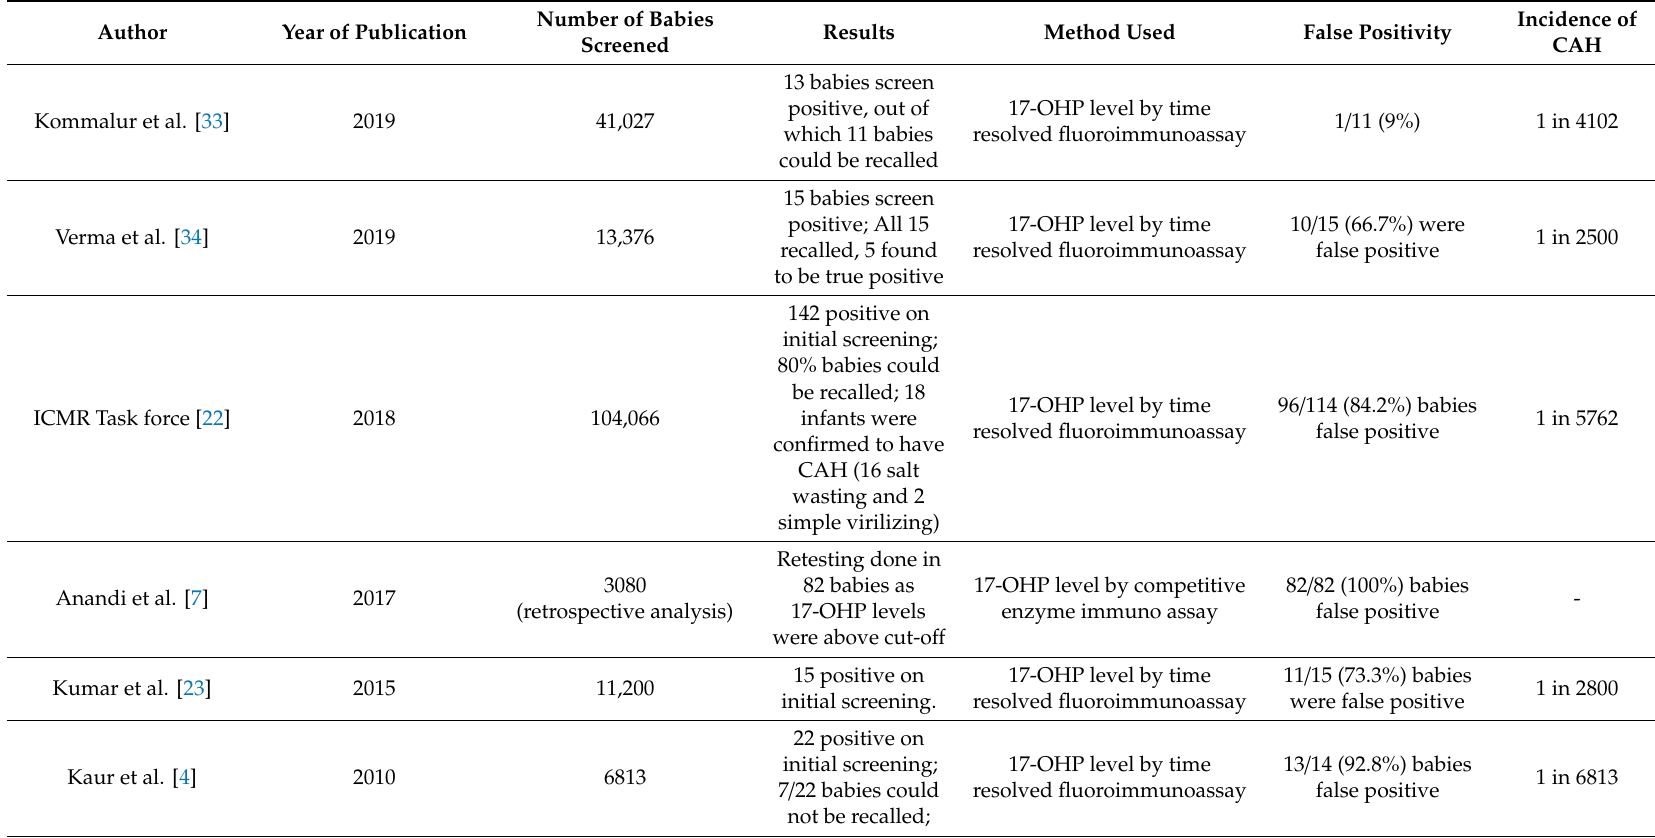
Table 1. Published literature on newborn screening for CAH in